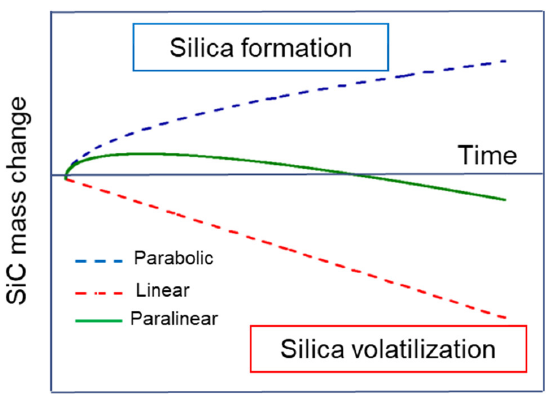
Figure 1. Paralinear mass change during HT oxidation of SiC due to formation and volatilization of a superficial SiO 2 scale.